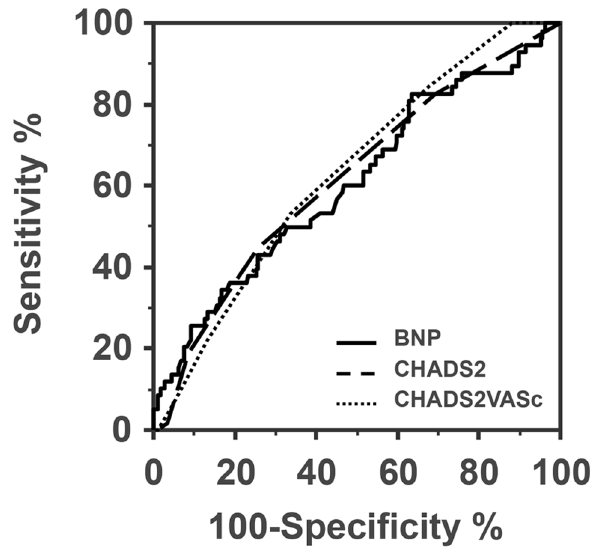
Figure 3. Comparison of ROC curves for prediction of CV events between BNP, CHADS2 and CHADS2-VASc in subjects with